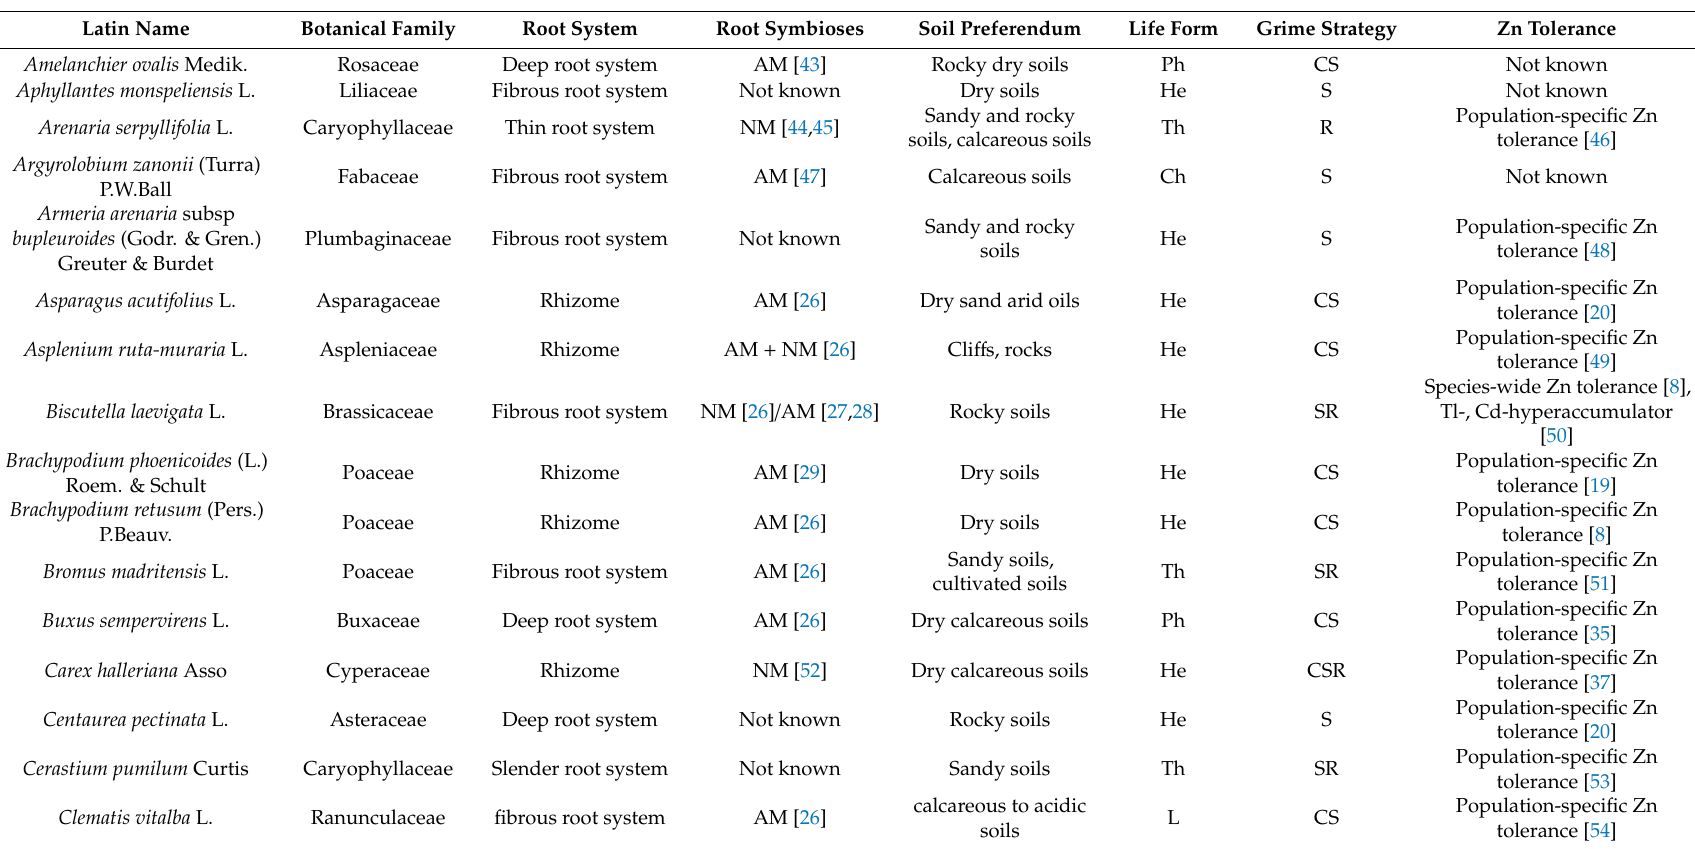
Table A1. Floristic list established during springtime from the mosaic of habitats encountered in the former mine site. Traits selected from literature: Root type; Root symbioses: AM: Arbuscular mycorrhizae, EC: Ectomycorrhizae; NM: Non mycorrhizal; Soil preferendum; Life forms [42]: Ph: